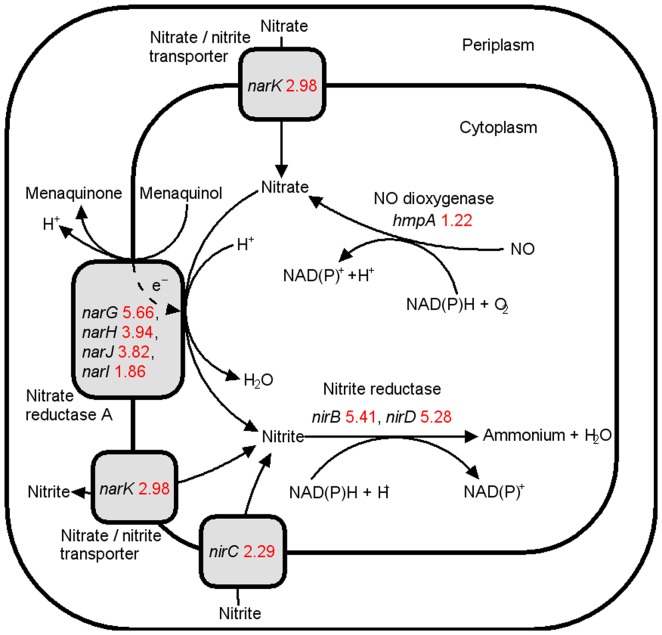
Differentially expressed genes associated with the metabolism and transport of NO, nitrate and nitrite.The number after each gene is the Log2 value (fold change in E1 compared with E0). Red values: upregulated in E1; dashed arrows: direction of electron flow.